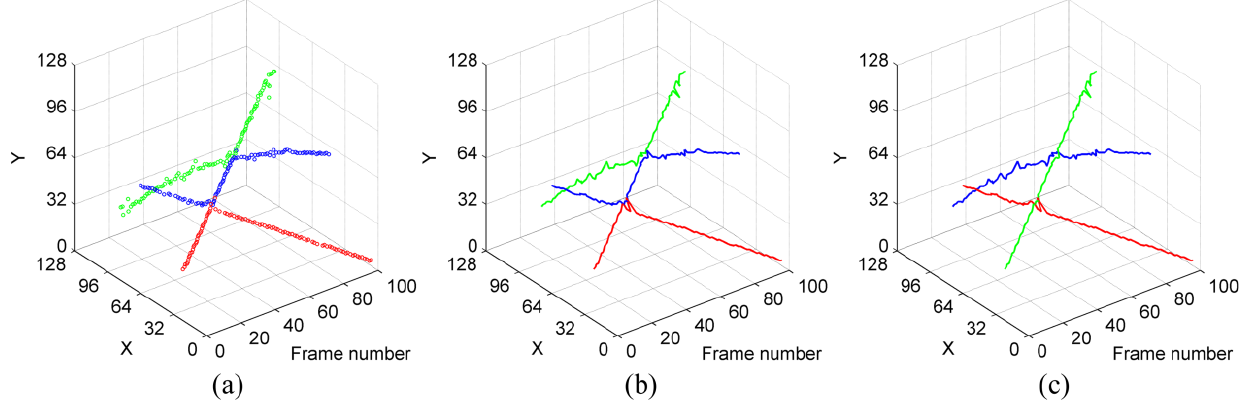
Figure 8. Test results for test case 3, in which all the three targets had an SNR level of 1.8. ( a ) Coordinates extracted by the MFF-DPR algorithm in the first, second, and third rounds are marked in red, blue, and green, respectively; ( b ) trajectories formed by correlating the coordinate points extracted in each round; ( c ) target trajectories after regularization.